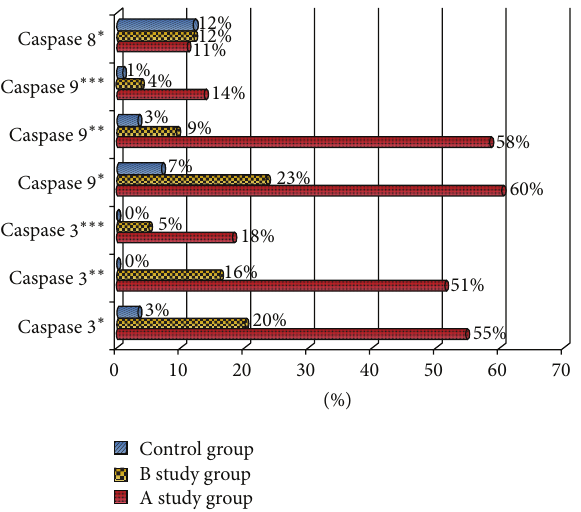
Figure 4: Intensity of caspase expression in particular research group. The expression of caspase 8 was low ( ∗ ) in all groups. The expression of caspases 3 and 9 was at the higher (intermediate ( ∗∗ ) and high ( ∗∗∗ )) level in the study groups than in the control group.